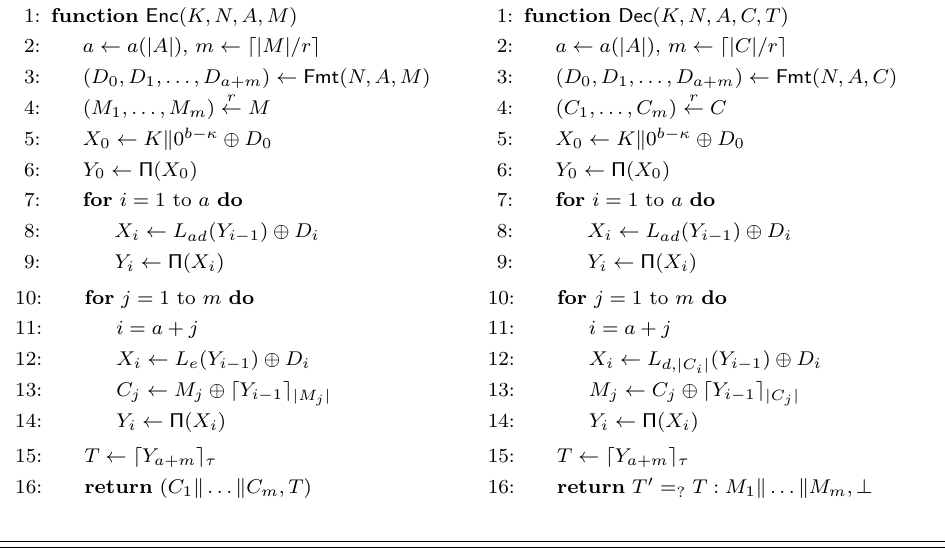
Algorithm 2 Description of Encryption/Decryption algorithms of the Transform-then- Permute mode with Associated data. X = ( x = ? y : p, q ) means X = p if x = y and X = q